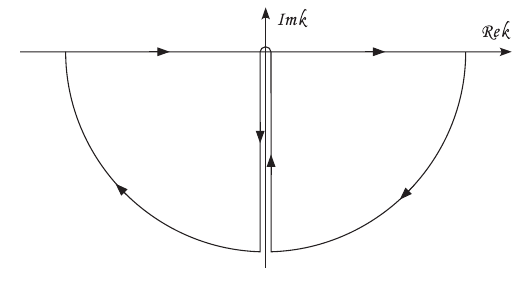
FIG. 4. Contour of free space impedance for (cid:14) < 0 .